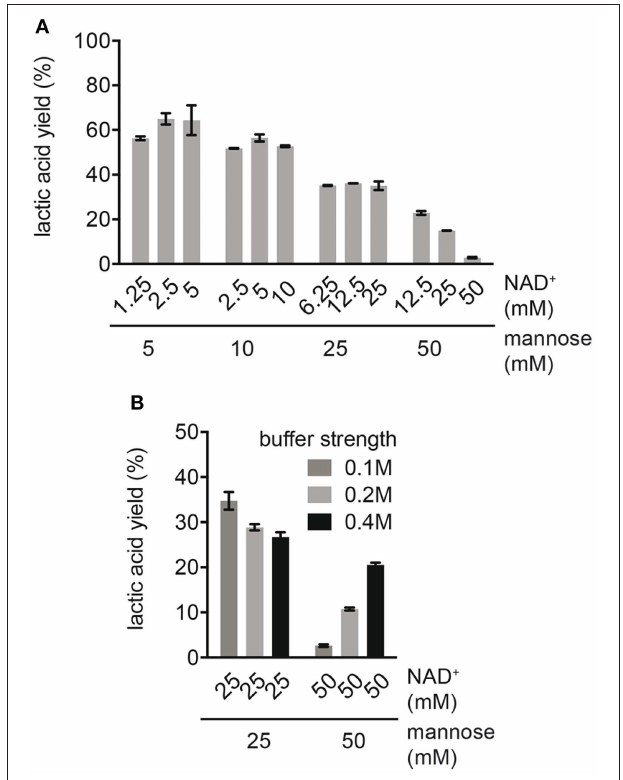
FIGURE 2 | Effect of different mannose and cofactor concentrations on LA yield. (A) Reactions were performed in 0.1M NaP buffer pH 7.0 with standard enzyme loading. (B) Effect of ionic strength on LA yield in reactions with high substrate concentrations. Reactions were performed with 25 and 50mM mannose, equimolar NAD + concentration and with standard enzyme